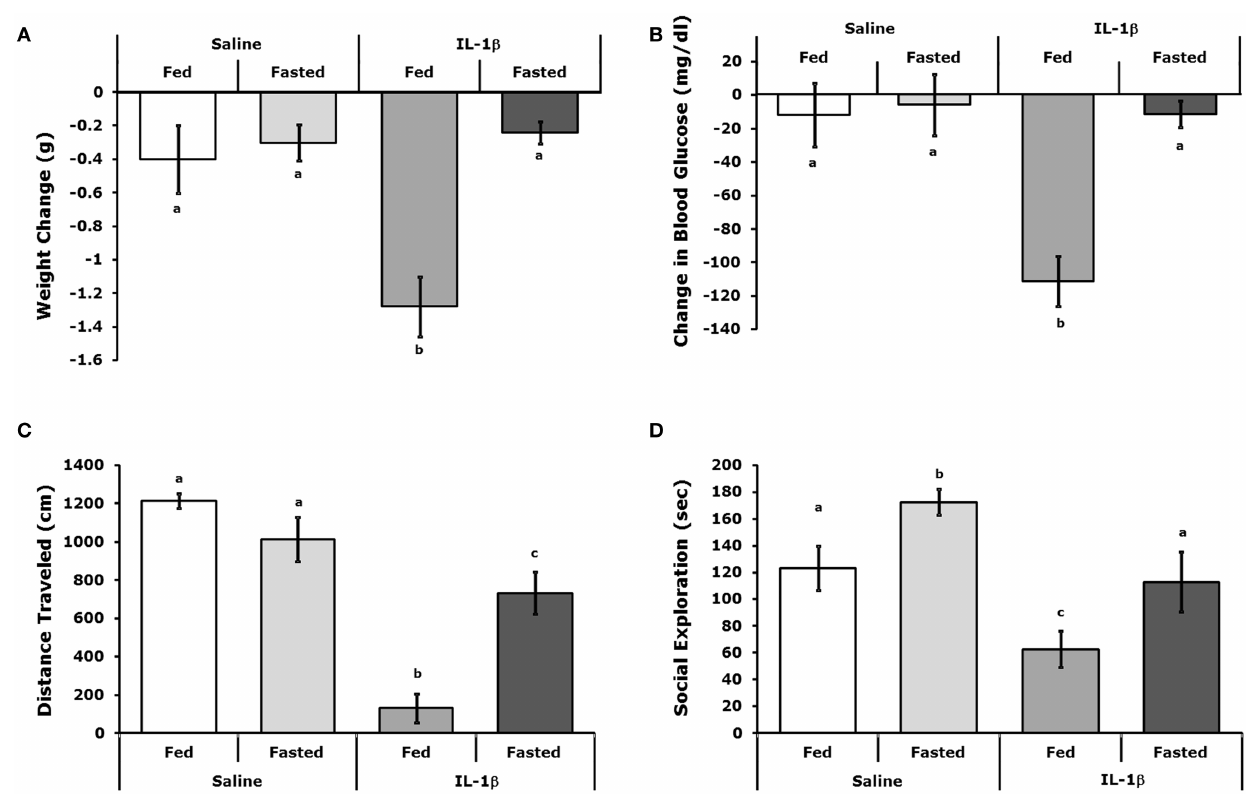
(microgram/deciliter), means ( ± SEM); n = 4–5. Bars without a common superscript are different ( P < 0.05). (C) Spontaneous locomotor activity was measure 2h after IL-1 β administration. Results are expressed as total distance traveled in centimeters (cm), means ( ± SEM); n = 4. Bars without a common superscript are different (* P < 0.05). (D) Social exploration was measured 2h after IL-1 administration. Results are expressed as total time of exploration (sec), means ( ± SEM); n = 8. Bars without a common superscript are different ( P <